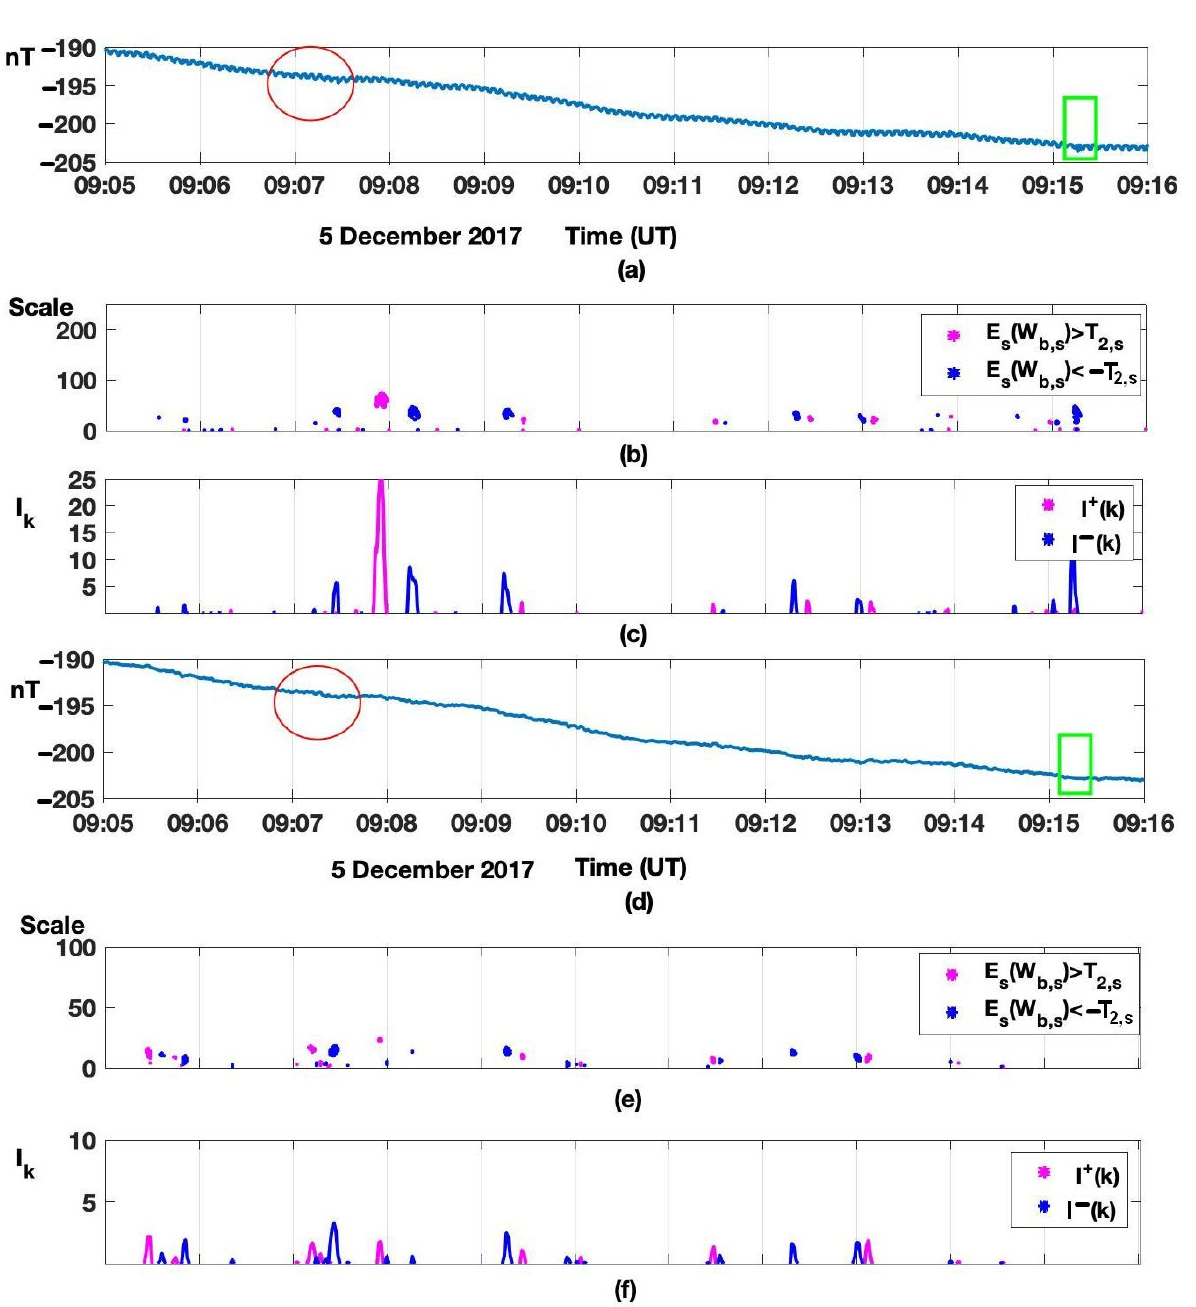
Figure 8. Processing of Paratunka and Magadan observatory geomagnetic data on 21 April 2017 (H-component). ( a ) SWS; ( b ) IMF Bz (GSM); ( c ) H-component PET, noisy; ( f ) H-component PET, cleared; ( i ) H-component MGD, noisy; ( d , e , g , h , j , k ) results of method application. Red vertical line is the magnetic storm